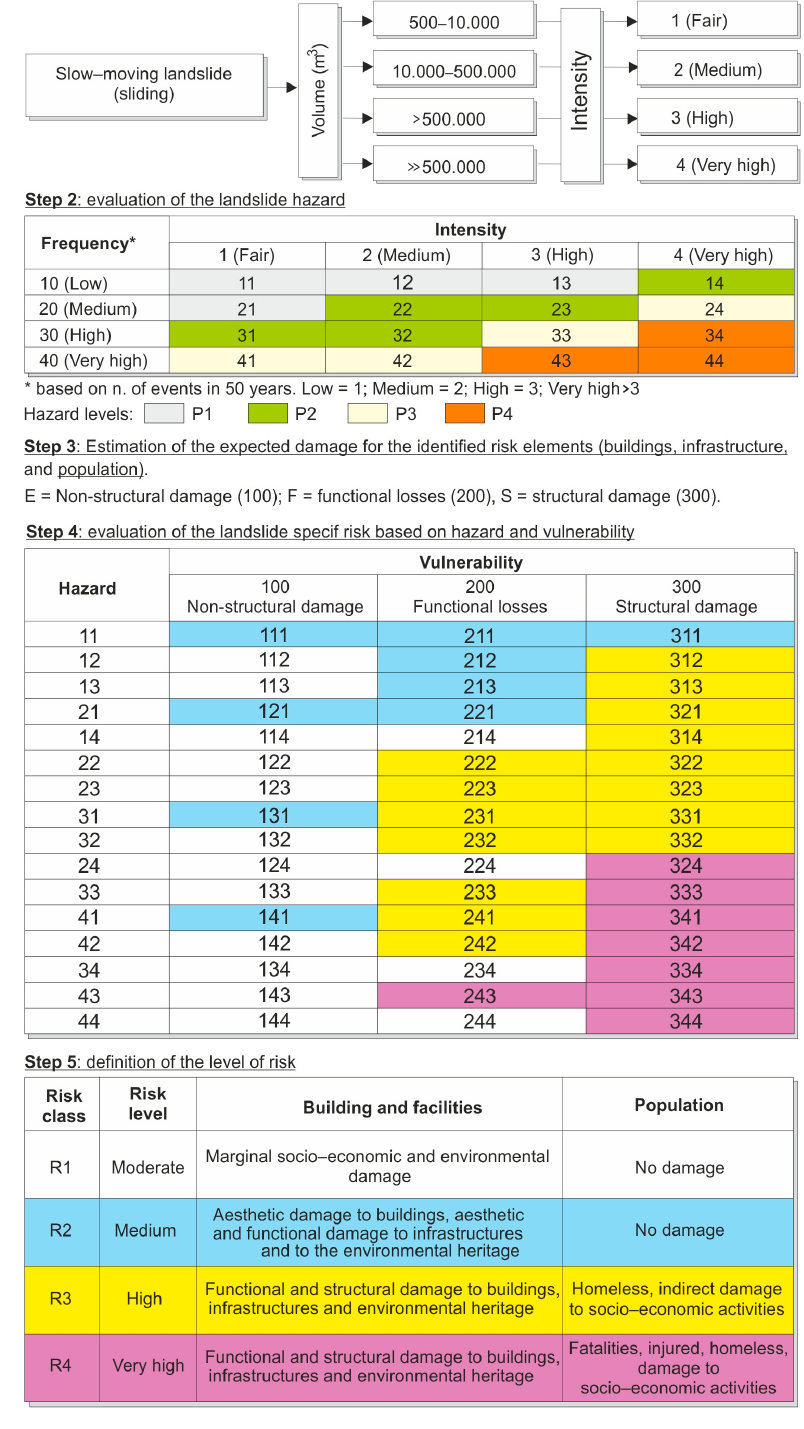
Figure 4. Landslide risk assessment procedure for the Tiber River Basin District Authority (Piano di Assetto Idrogeologico, PAI [46]).